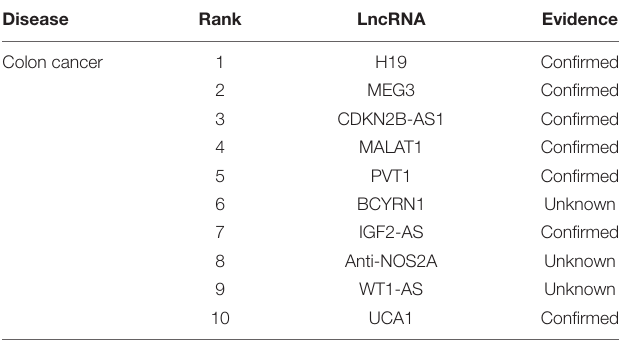
TABLE 2 | The predicted top 10 lncRNAs for colon cancer.